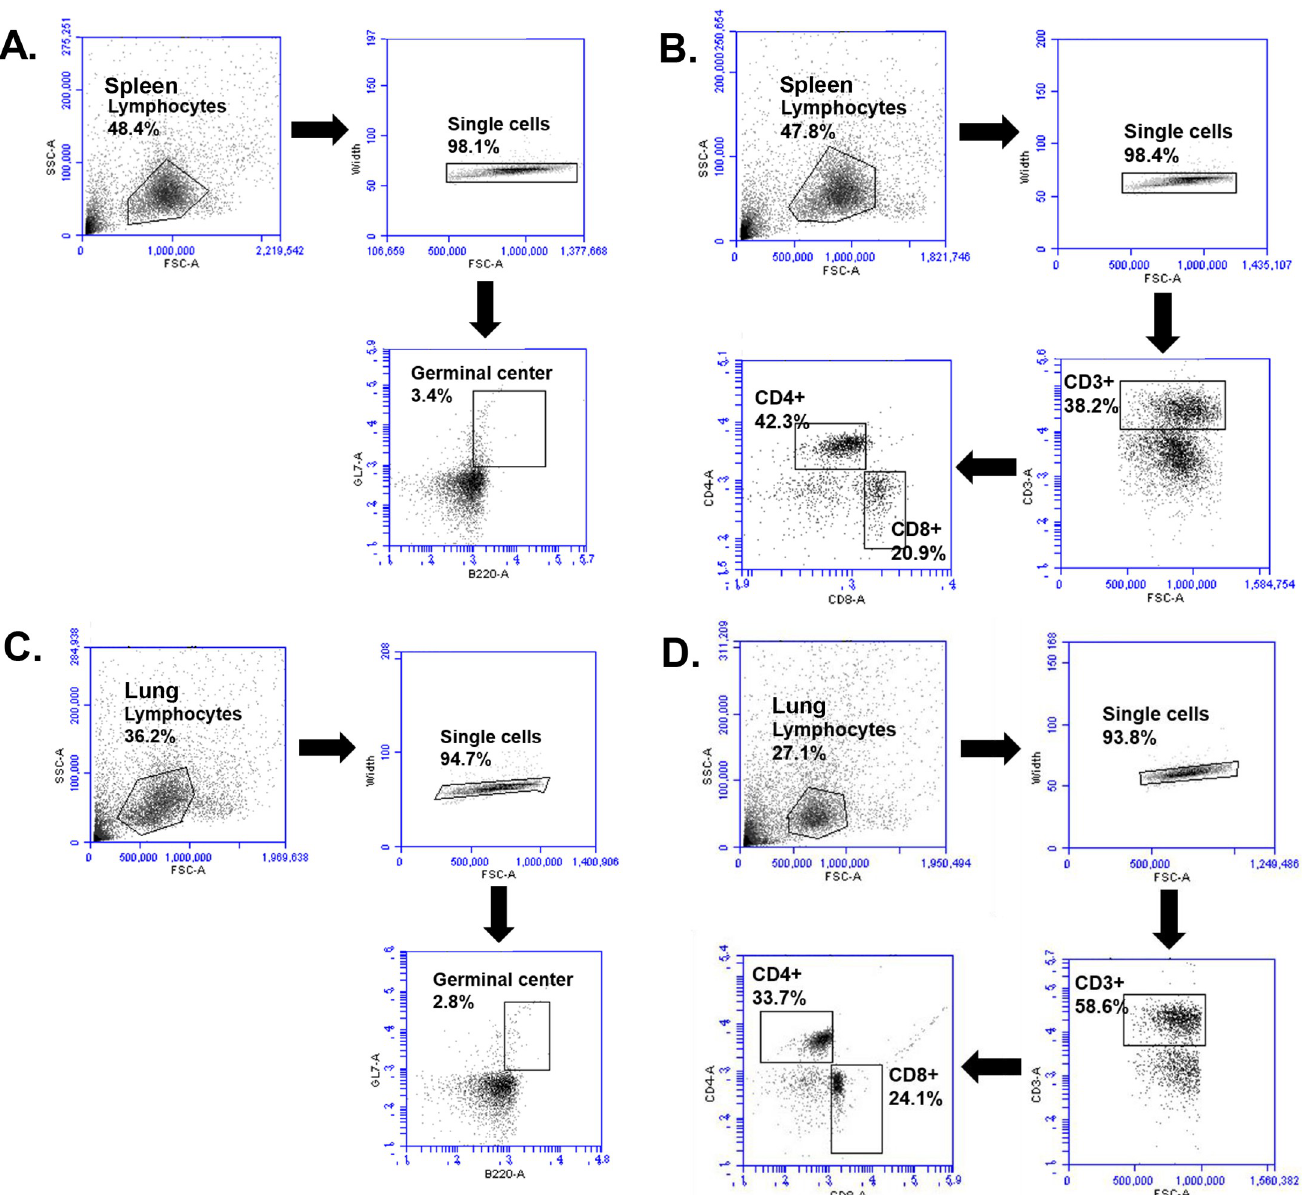
Fig 4. Gating strategy panels. (A) Flow cytometry plots showing the gating strategy to identify germinal center cells in spleens. (B) Flow cytometry plots showing the gating strategy to identify CD4 + and CD8 + T cell in spleens. (C) Flow cytometry plots showing the gating strategy to identify germinal center cells in lung cells. (D) Flow cytometry plots showing the gating strategy to identify CD4 + and CD8 + T cell in lung